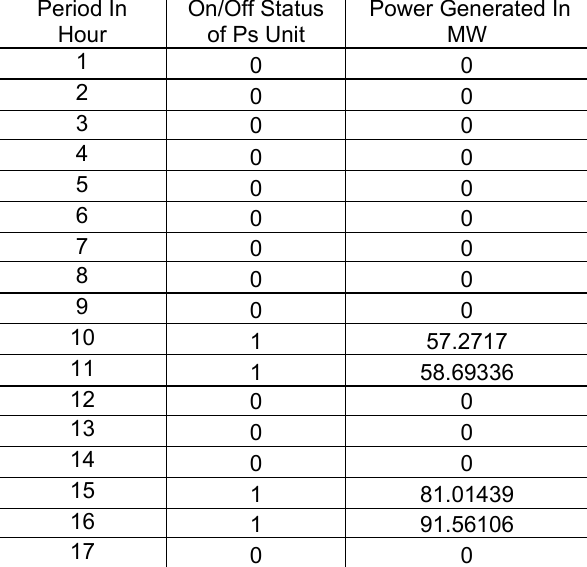
Table 2. ON/OFF unit status with power